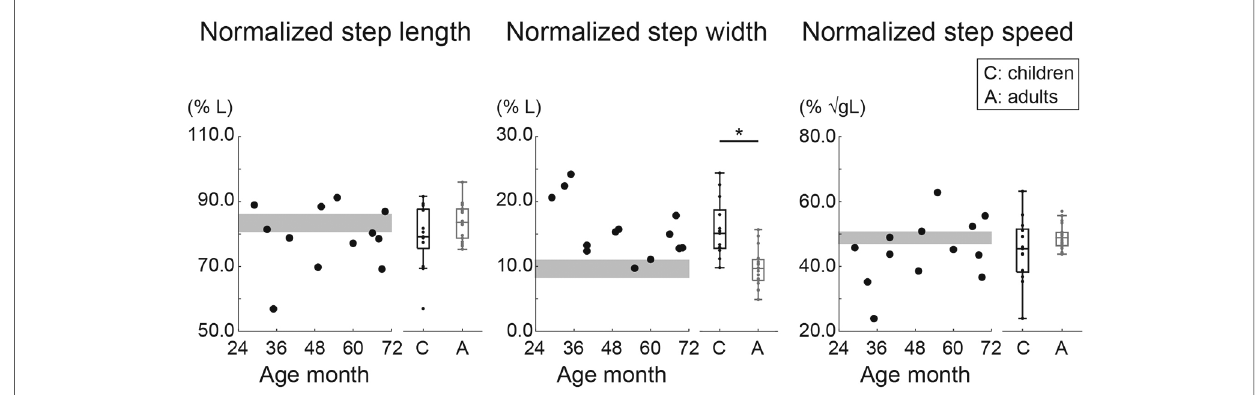
FIGURE 3 Normalized step length, step width, and step speed during level walking. The step length and step width were normalized to leg length ( L ), and the step speed was normalized to the root square of gravity ( g )× L . Circles indicate the mean within-participant value. The gray area shows the 95% con fi dence interval (CI) of the mean of adults. * Indicates p